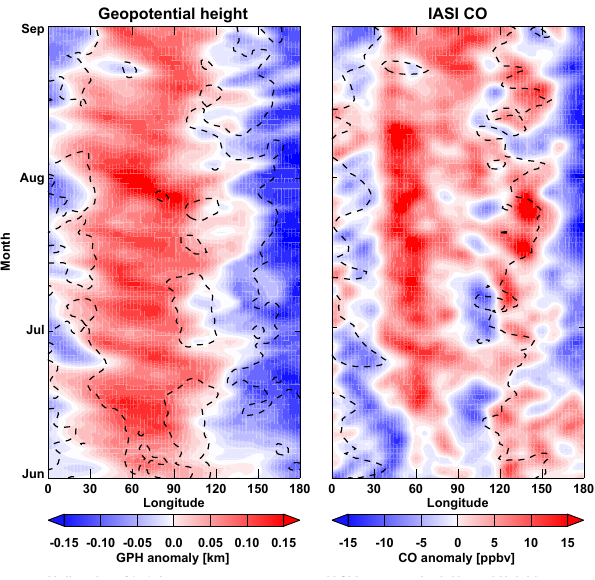
IASI interp. method: Natural Neighbor IASI daily +/- 0 days Orig. IASI interp. x-grid sz. : 5.0 deg. Orig. IASI interp. y-grid sz. : 5.0 deg. Latitude range: 10.0 to 40.0 IASI along GPH Ridge?: No